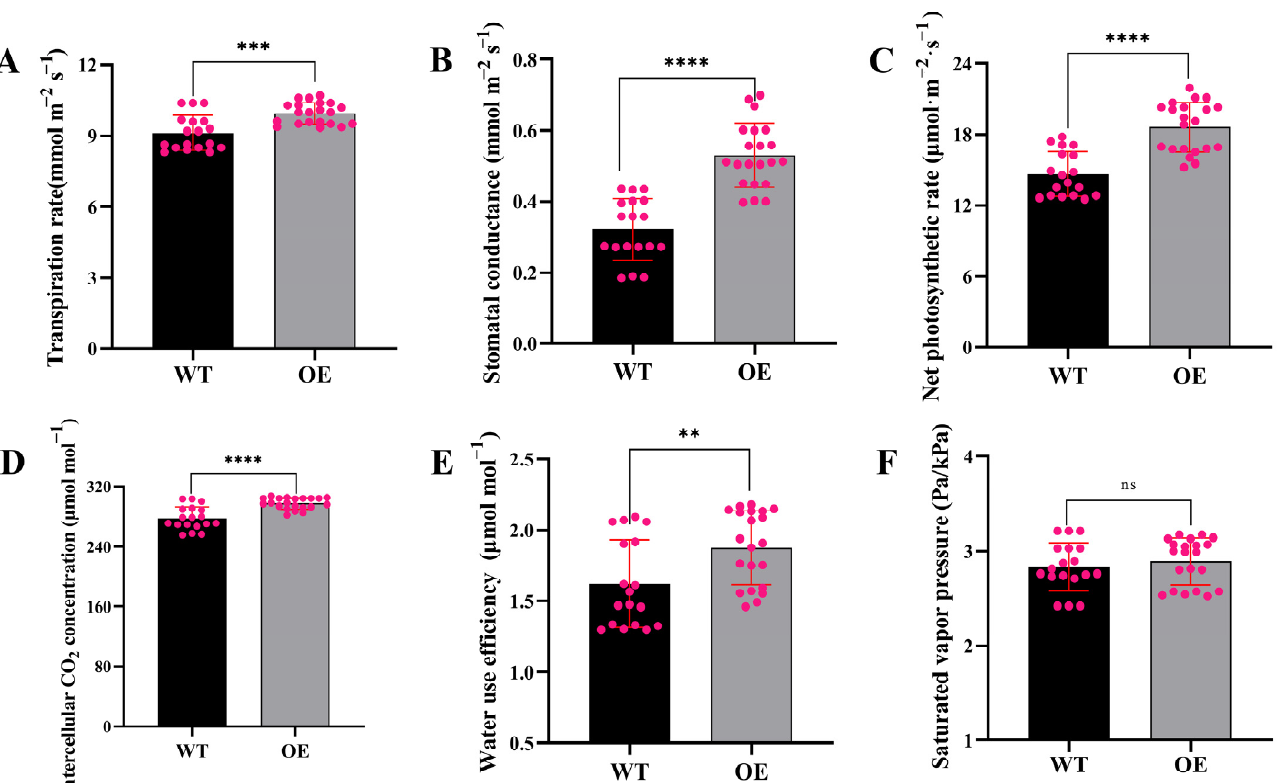
Figure 4. Photosynthetic parameters of wild ‐ type and transgenic tomato leaves in the field. ( A ) Transpiration rate. ( B ) Stomatal conductance. ( C ) Net photosynthetic rate. ( D ) Intercellular CO 2 concentration. ( E ) Water use efficiency. ( F ) Saturated vapor pressure. Data are means ± SD of three replicates. Each red dot represents a sample. Ns indicate no significant difference between the wild ‐ type and transgenic lines. Asterisk(s) indicate significant difference between the wild ‐ type and transgenic plants by Student’s T ‐ tests: ** p < 0.01, *** p < 0.001, **** p < 0.0001.